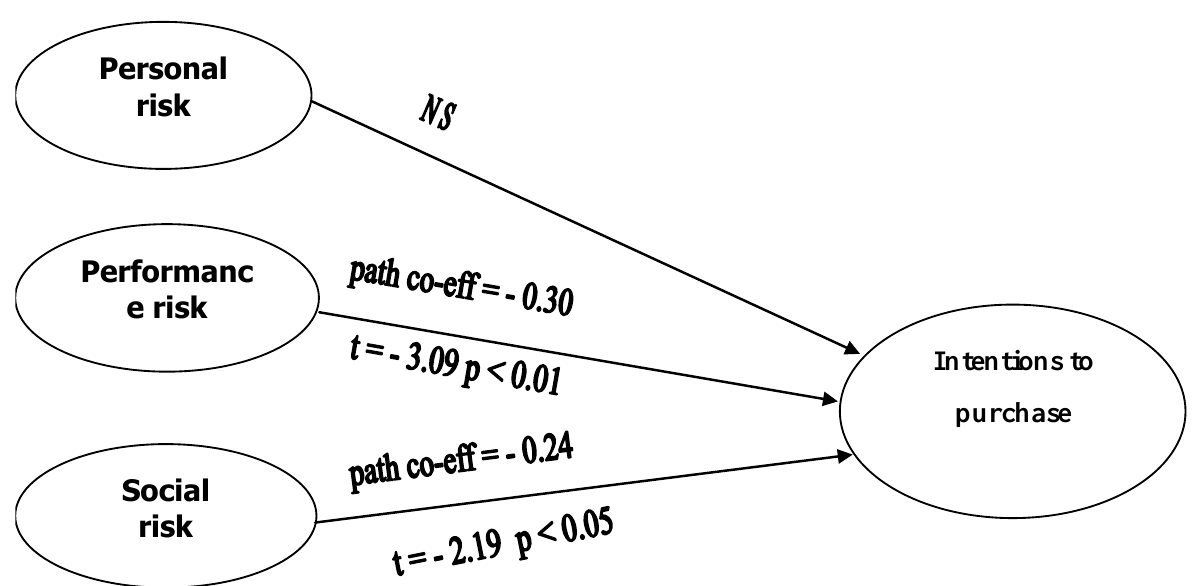
Figure 1: The influence of risk perceptions on intentions to purchase online on a branded